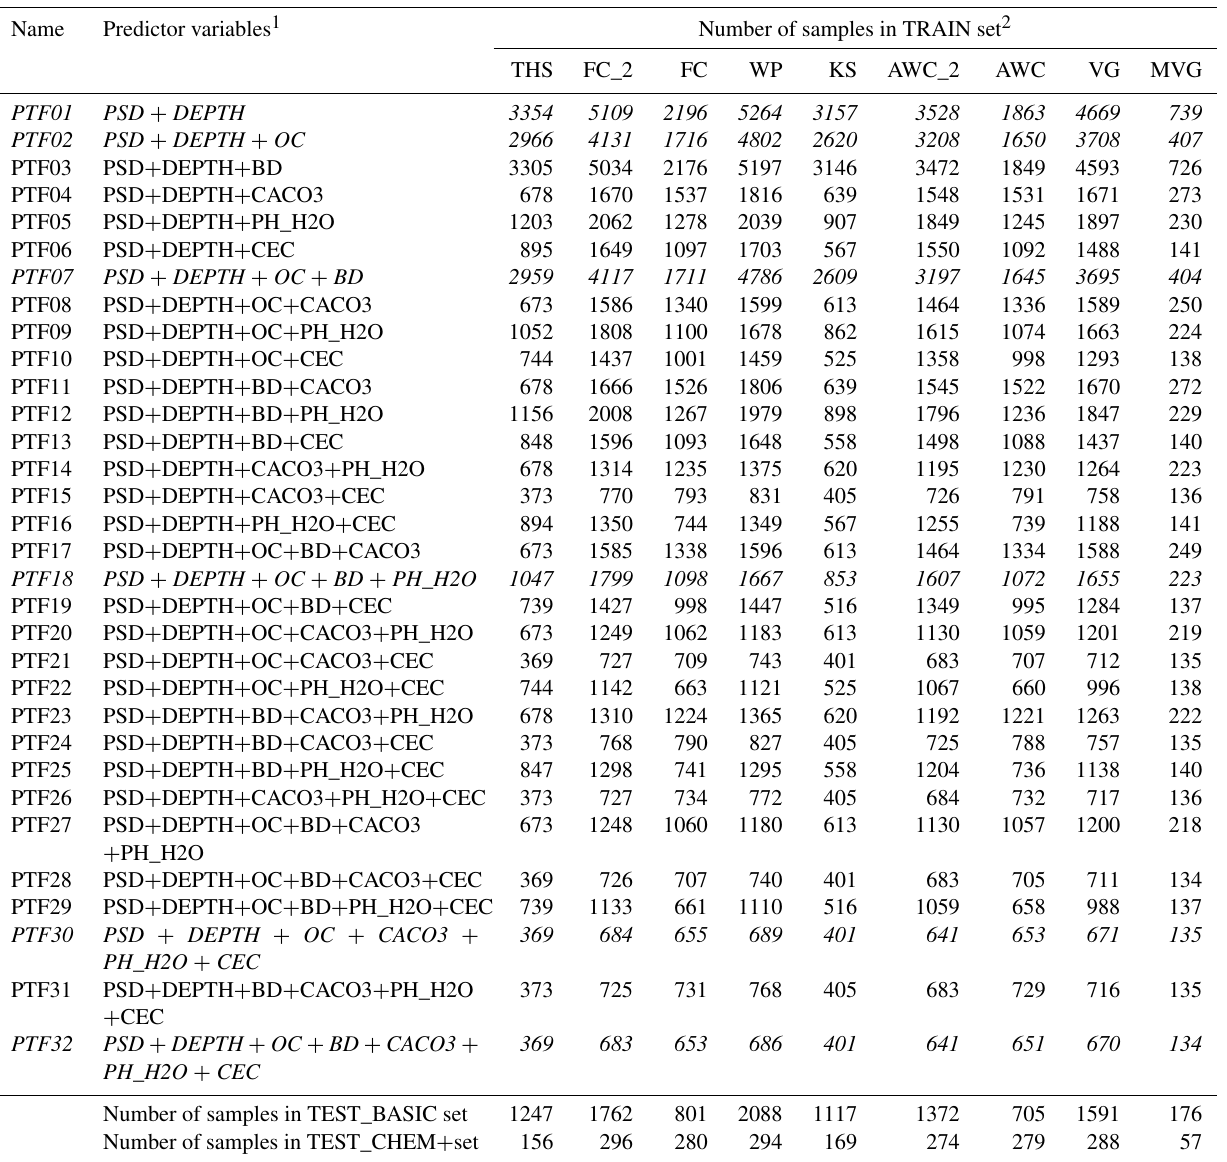
Table 1. Number of samples by predictor variable combinations used to derive the new European PTFs (euptfv2). Rows in italic font indicate PTFs with the same predictor variables as were tested in euptfv1 (Tóth et al.,